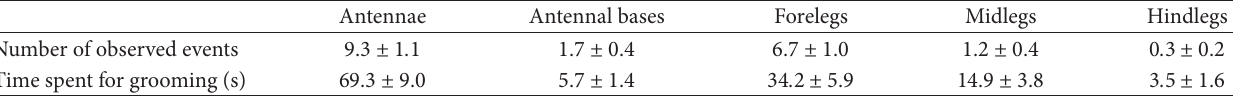
Table 1: Background grooming (averaged over 26 experiments, mean ± standard error). Antennae